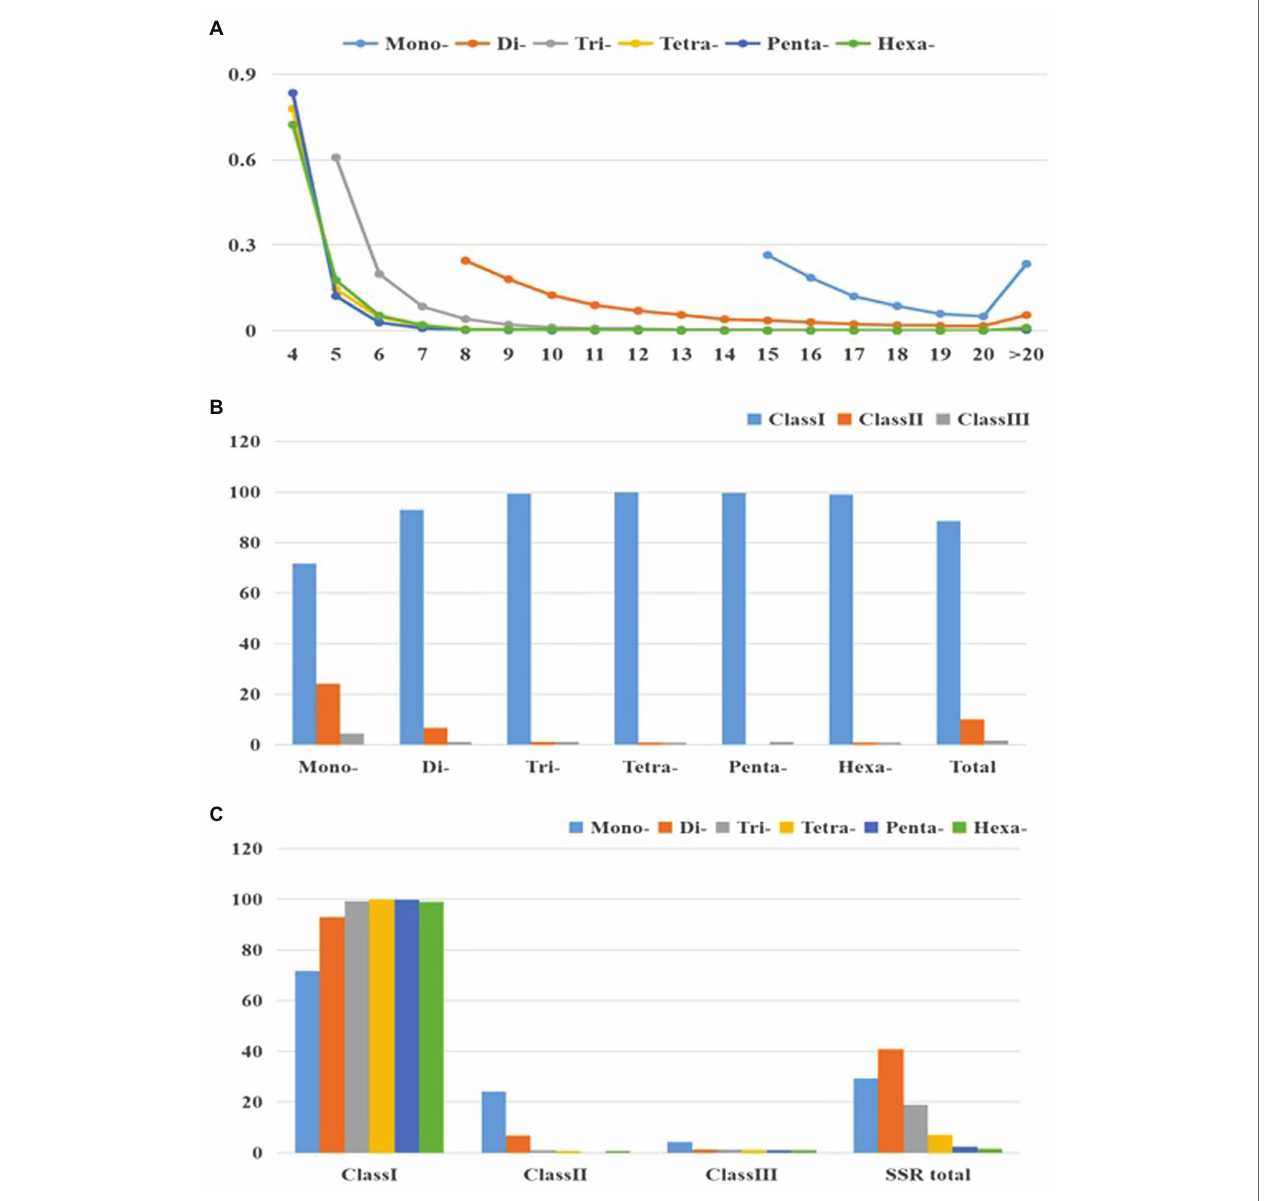
FIGURE 2 | Characterization of perfect SSRs in the cabbage genome. (A) The changeable rule from mononucleotides to hexanucleotide motifs. (B) The frequency of repeat classes (class I > 30 nt, class II 20–30 nt, class III <20 nt). (C) The distribution of motif type within each